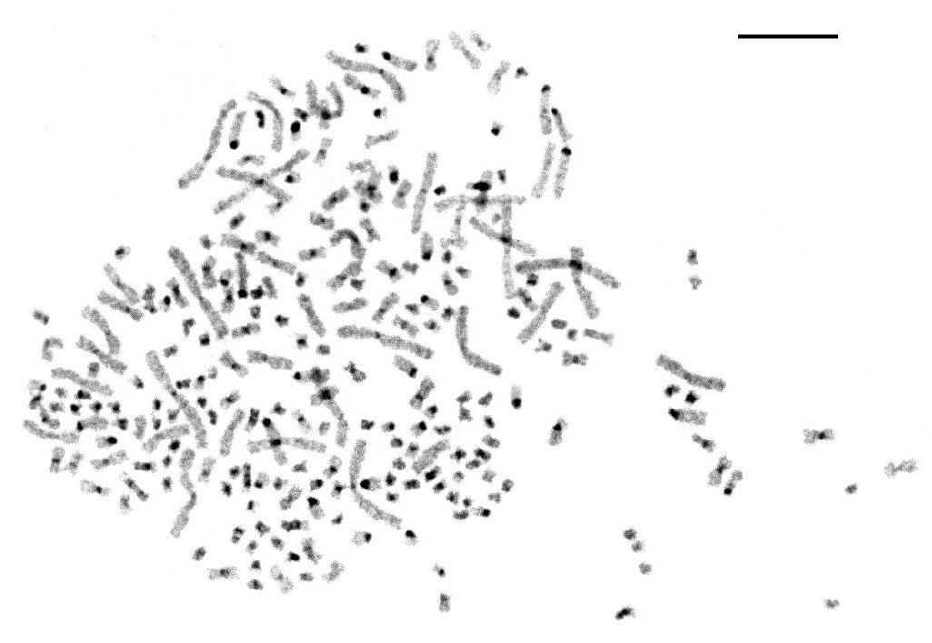
Figure 3. CBG-stained chromosomes of the Siberian sturgeon. The scale bar is 10 µm.